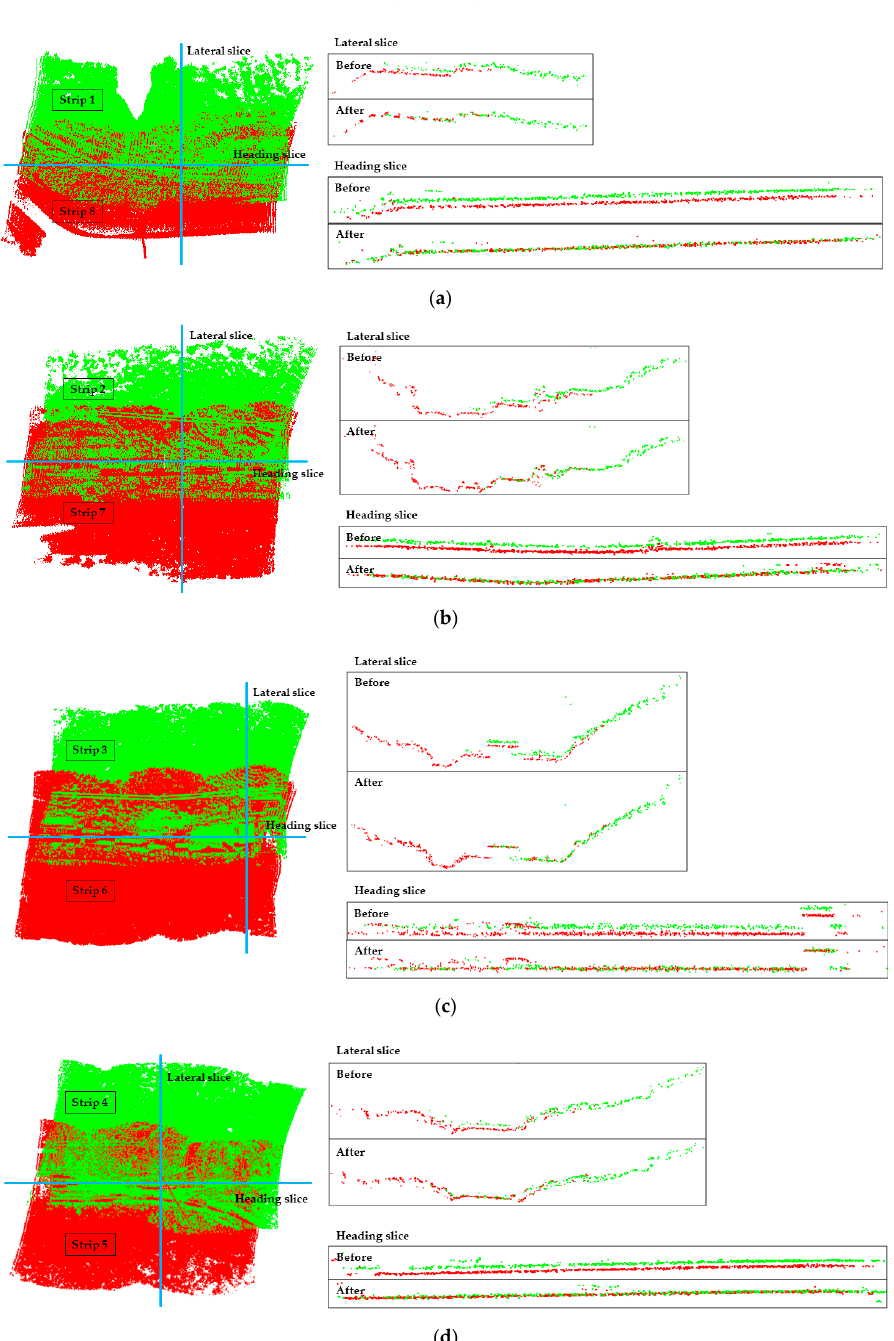
Figure 6. Slice position and results of lateral strip pairs before and after adjustment by the proposed method: ( a ) Strips 1 and 8; ( b ) Strips 2 and 7; ( c ) Strips 3 and 6; ( d ) Strips 4 and 5.